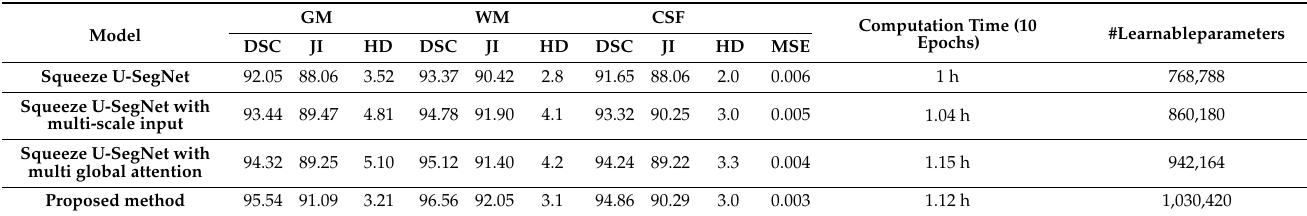
Table 4. Detailed data on the number of learnable parameters and computation time for the proposed method and its three simplified versions.